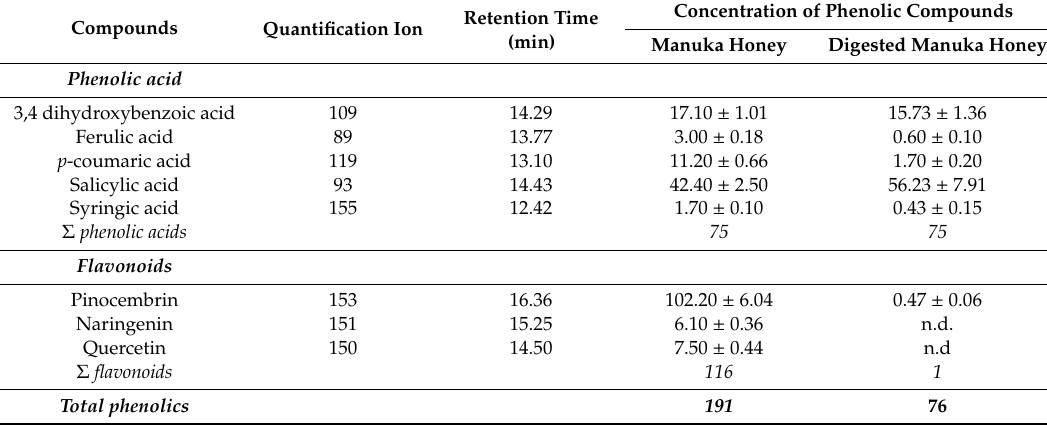
Table 2. Quantification ion, retention time and concentration of phenolic compounds in Manuka honey and in the fraction obtained after in vitro digestion ( µ g / kg honey).